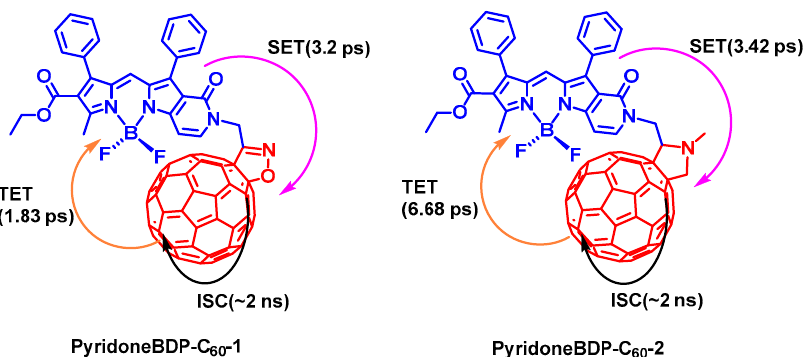
Figure 20. PyridoneBodipy-C 60 dyads showing ping-pong energy transfer, i.e., the forward singlet energy transfer from pyridoneBodipy unit to the C 60 unit, ISC of the C 60 unit, and, subsequently, the backward triplet energy transfer from the C 60 unit to the Bodipy unit in the dyads. The excited state kinetics are presented.